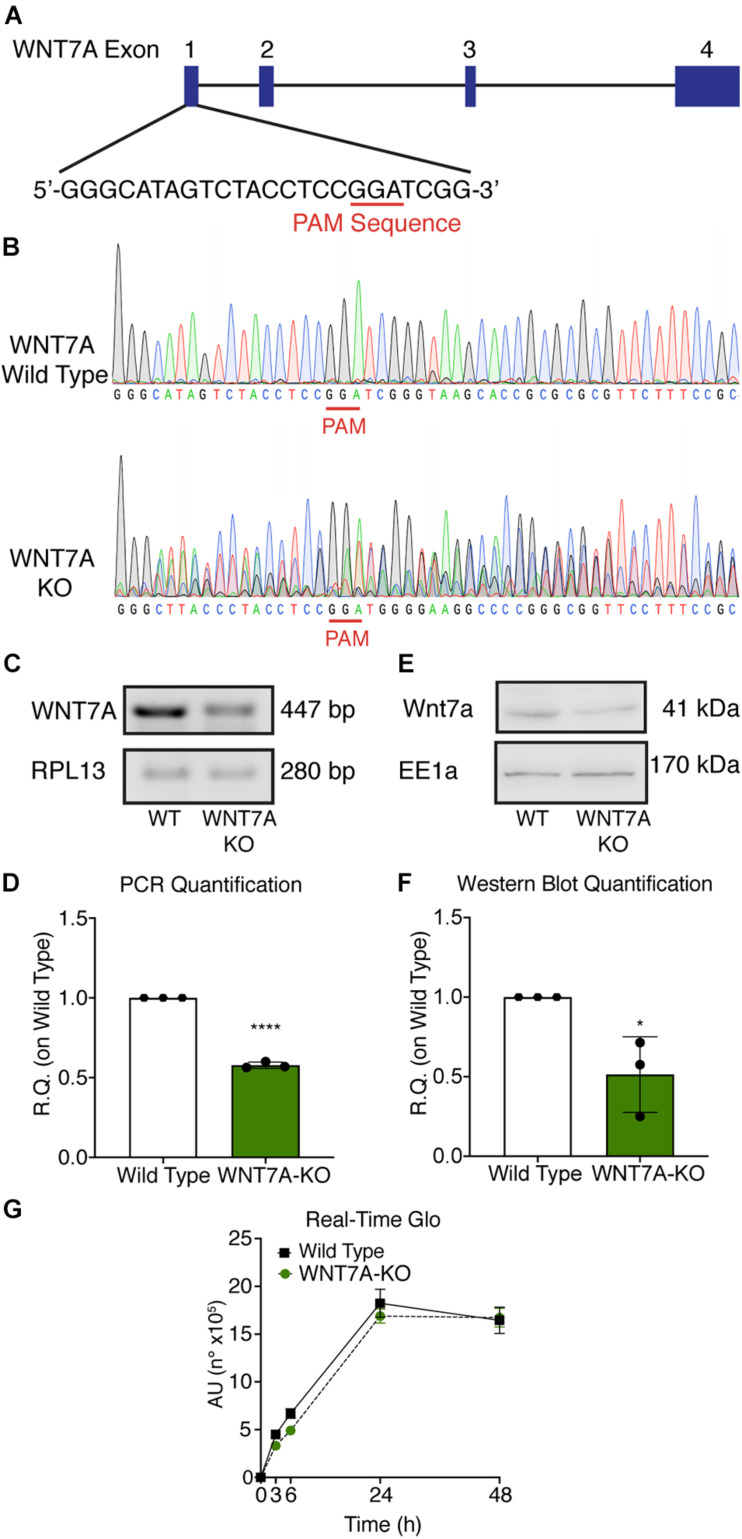
Characterization of WNT7A inhibition using CRISPR/Cas9 model in C2C12. (A) Graphical representation of the mouse WNT7A-targeted locus. Boxes and lines indicate exons and introns, respectively. The oligo represents sgRNA target sequence and Protospacer Adjacent Motifs (PAM) site is marked in red. (B) Sanger DNA sequencing were conducted on PCR products amplified from the genomic WNT7A loci of C2C12. (C,D) Genomic PCR analysis (C) and quantification of WNT7A inhibition (D). RPLI was used as the housekeeper (n = 3). (E,F) Western Blot analysis (E) and quantification (F) of WNT7A expression in wild type (WT) and WNT7A-silenced murine myoblasts (WNT7A-KO; n = 3). (G) Cell viability analyzed by RealTime-GloTM kits MT Cell Viability Assay of wild type and WNT7A-silenced murine myoblasts (n = 3). Data information: all data represent mean ± SD. *p < 0.05, ****p < 0.0001 (Student’s t-test).